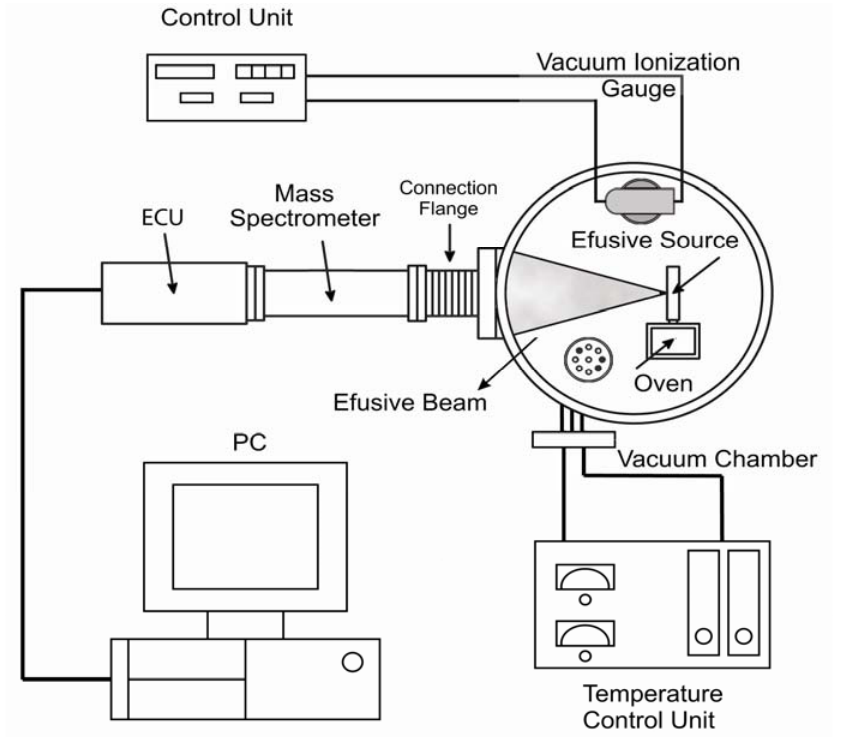
Figure 1. Molecular beam—thermal desorption mass spectrometer (MB-TDS) (Adapted from